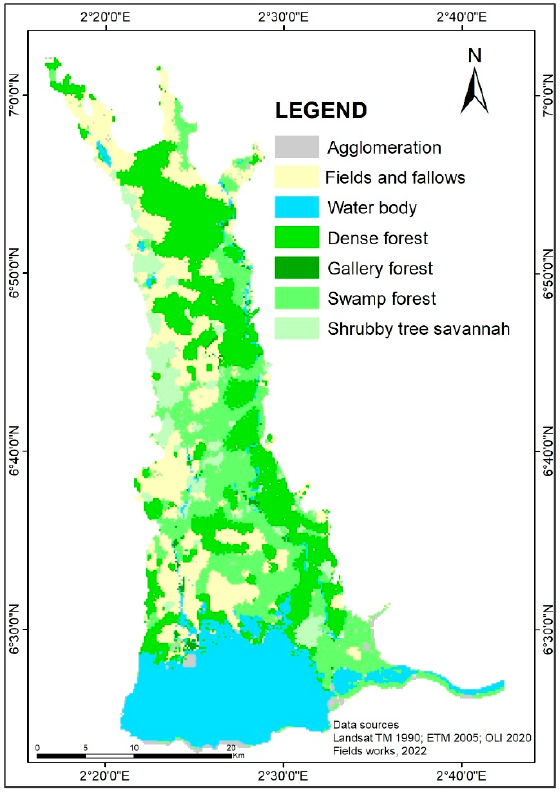
Figure 7. Predictive mapping of the vegetation cover of the Ouémé Delta in 2035.